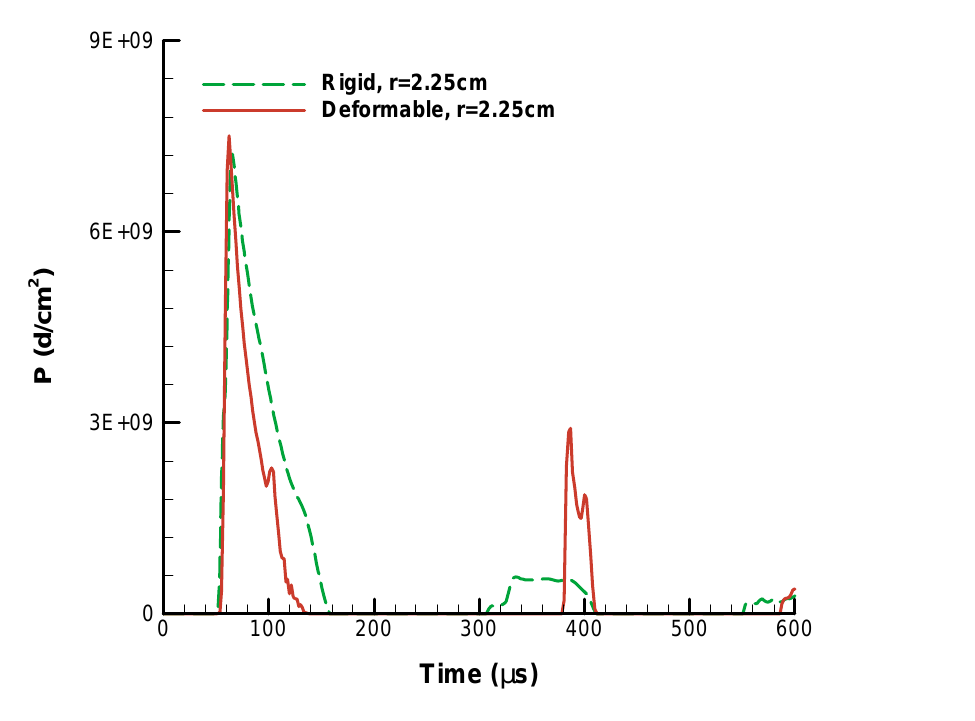
Fig. 12. Centerline wall pressure histories for the rigid and flexible plates.